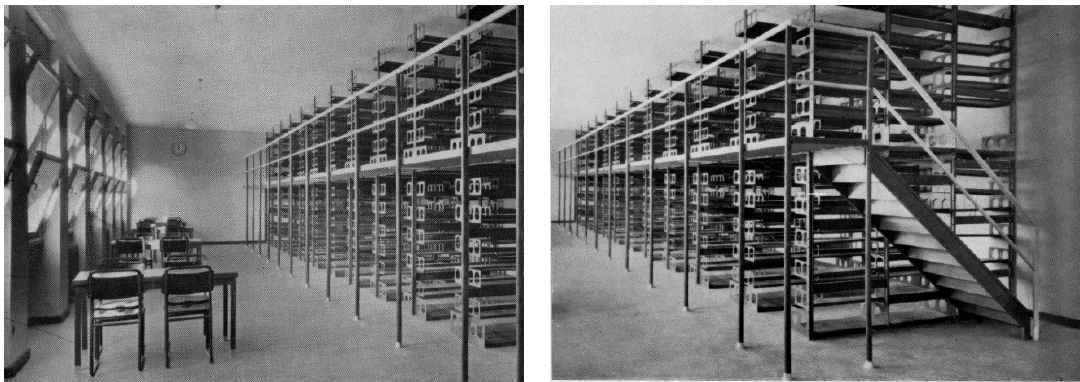
Figure 47. Institute of Physics. Metal shelving for Library. Photo from (De Smaele 1936, p. 23).